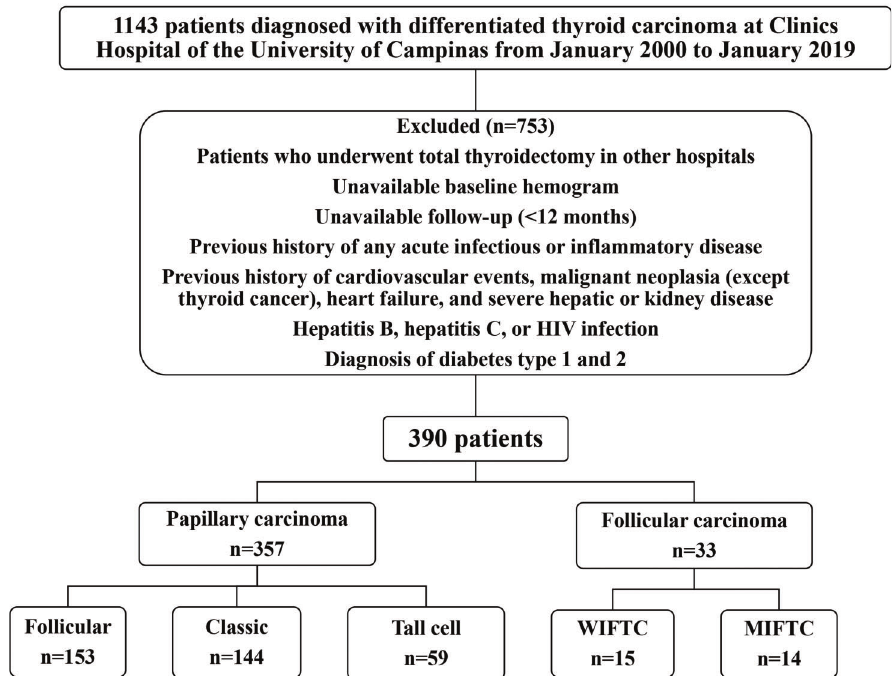
Figure 1 - Study flowchart. WIFTC: widely invasive follicular thyroid carcinoma, MIFTC: minimally invasive follicular thyroid carcinoma, HIV: human immunodeficiency virus.